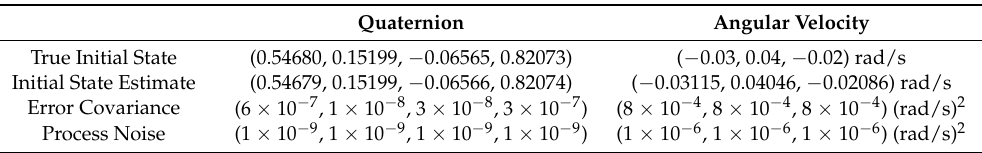
Table 3. Initial conditions for the